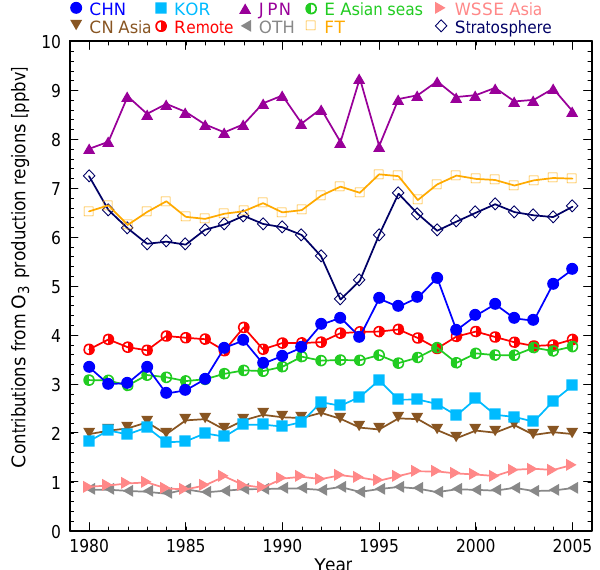
Figure 5. Same as Fig. 3 but showing the temporal changes in sea- sonal mean surface O 3 anomaly averaged over Japan from observa- tions (AEROS: black) and model calculations (red).